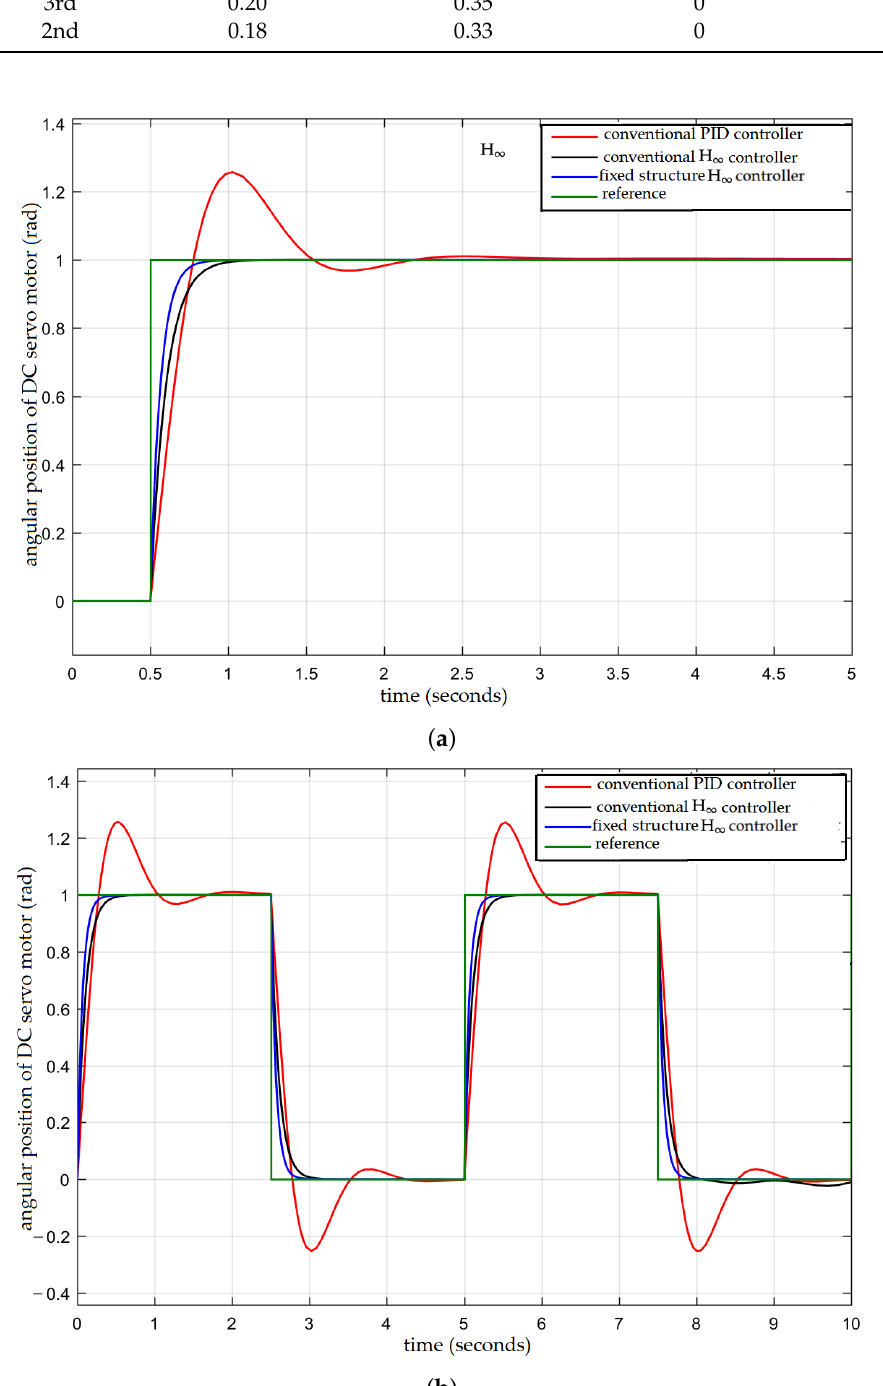
Figure 9. Step input tracking ( a ) and square input tracking ( b